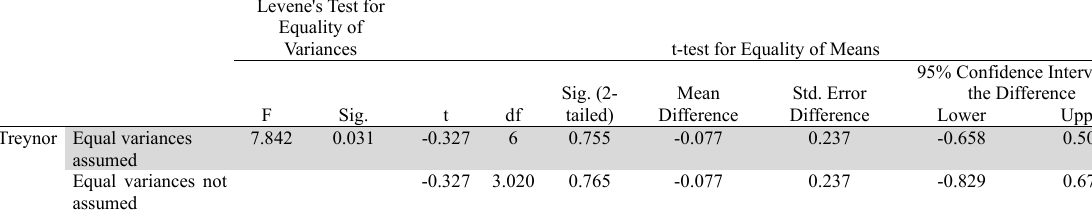
Independent Samples